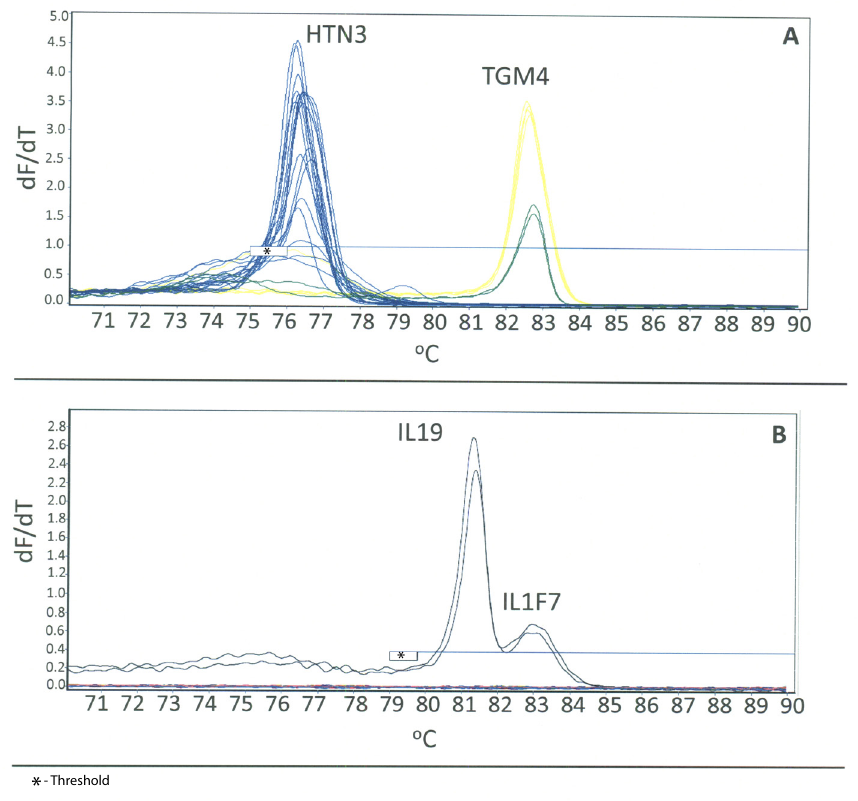
Figure 3. Performance of the saliva/semen and vaginal secretions/skin duplex HRM assays with mock casework samples. A ) Saliva/ Semen Assay. Detection of semen in two different vaginal samples is indicated by the presence of the TGM4 peak. A composite image of known semen and saliva samples (yellow and blue, respectively) and the two vaginal samples (green) in which semen was detected is shown. B ) Vaginal Secretions/Skin Duplex Assay. Samples were collected from a male finger after digital penetration and from male underwear ~3 hours after intercourse. The detection of the presence of both vaginal secretions and skin is indicated by the presence of the IL19 and IL1F7 peaks in each